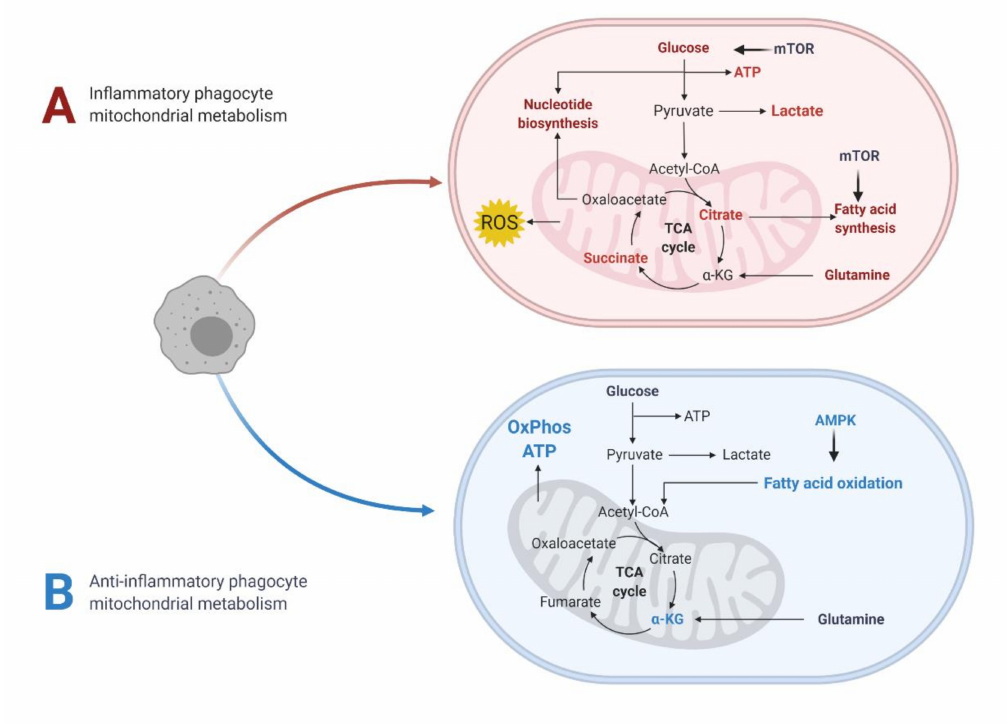
Figure 5. Mitochondrial metabolism in determining macrophage phenotype: Inflammatory macrophages constitute one of the largest immune cell infiltrates in CNS in MS. Proinflammatory macrophages have a distinct metabolic profile where they have reduced ATP production via OxPhos, altered TCA cycle metabolites (such as enhanced citrate and succinate levels), and have upregulated glycolysis and fatty acid synthesis pathways via mammalian target of Rapamycin (mTOR) activation. Such dysregulated mitochondrial metabolism allows these cells to be highly bactericidal by secreting inflammatory cytokines and ROS. On the other hands, immunoregulatory macrophages rely predominantly on TCA cycle and electron transport chain mediated OxPhos to generate ATP. This is aided by increased FAO via 5’ AMP-activated protein kinase (AMPK) activation. Image adapted from Biorender TM